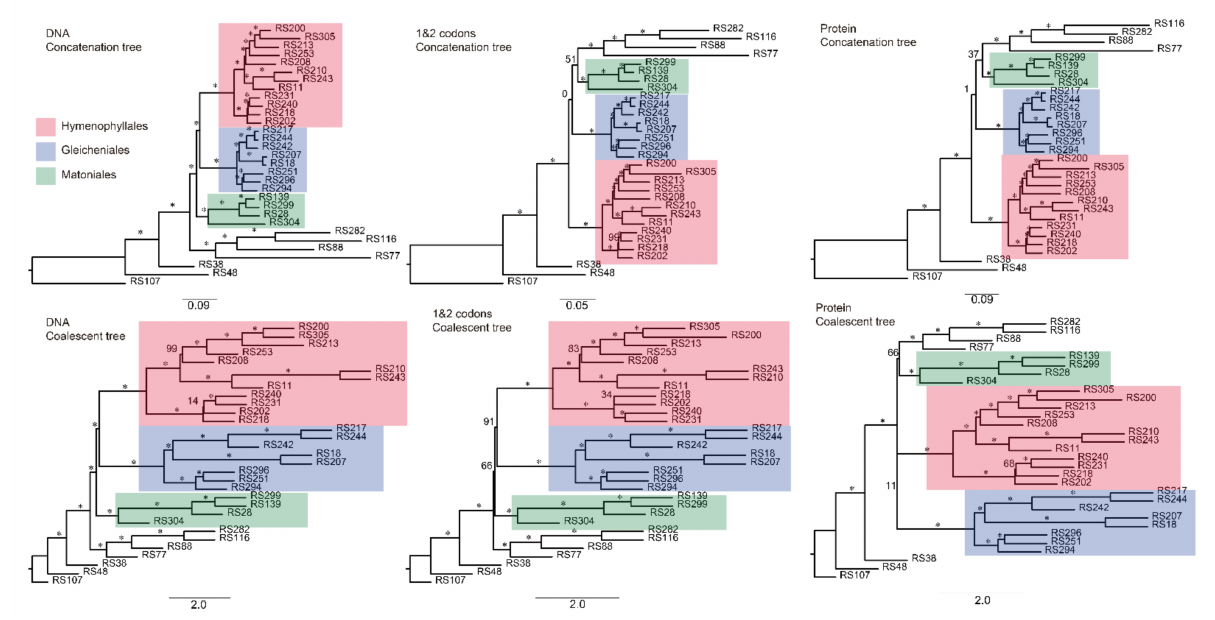
Figure 3. Six phylogenetic trees of different strategies. The number on the branch is the bootstrap value, and the asterisk (*) indicates a bootstrap support (BS) value of 100. The DNA concatenation tree, the DNA coalescent tree, and the 1 and 2 codons coalescent tree are consistent with high confidence (almost all of BS = 100), whereas the other trees are incongruent with low BS values.